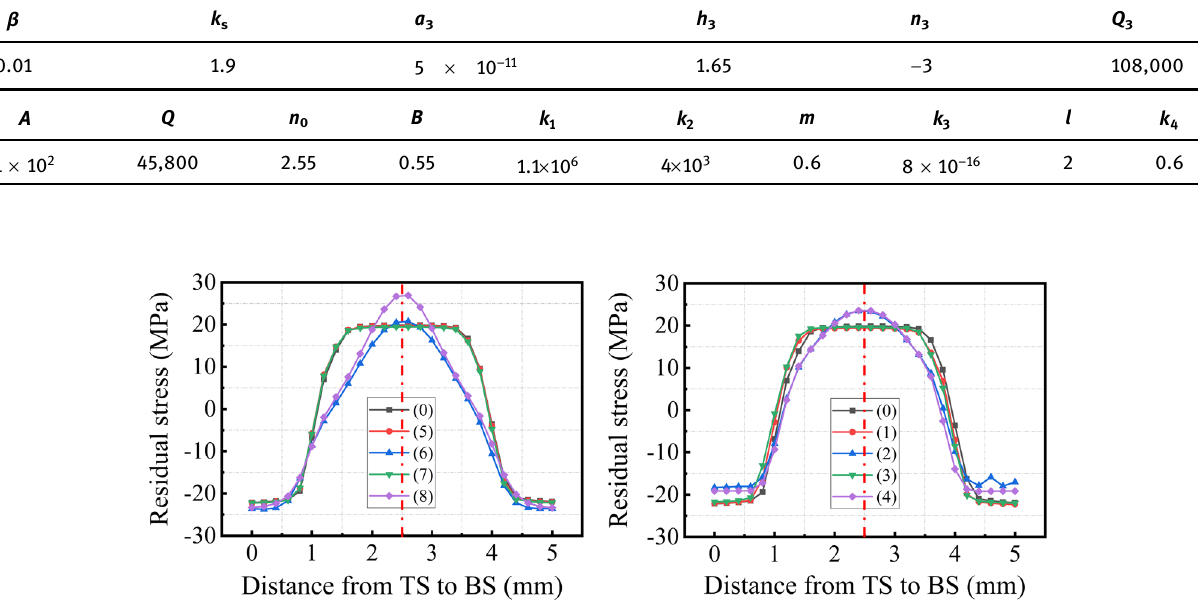
Figure 8: Symmetrical stress distribution in the thickness direction after stress - relief annealing.